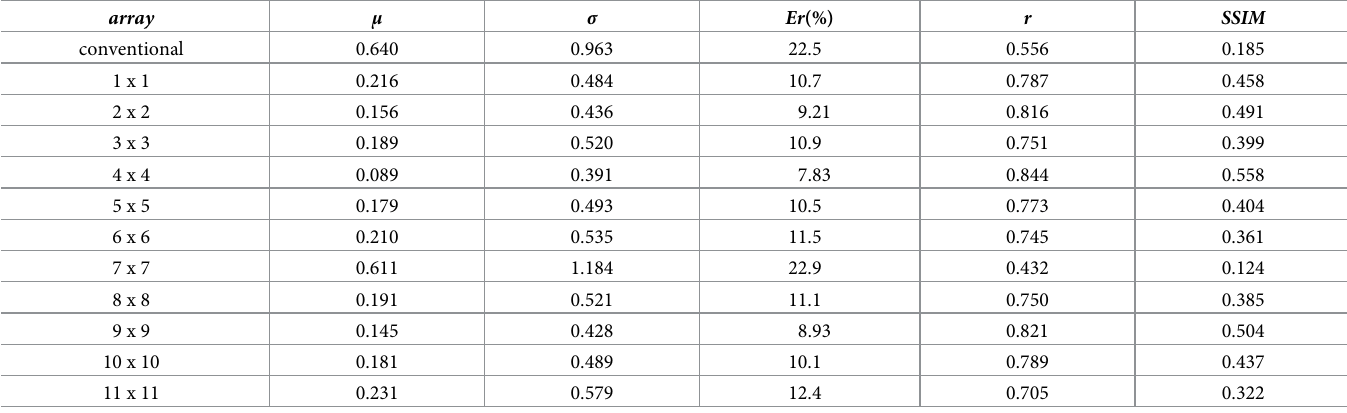
Table 1. Table with the main statistics of the numerical experiments. We focus our analysis on the red square region in Fig 2(a). The statistics μ , σ , and Er are based on the misfit between the model and the reconstruction. The quantities r and SSIM measure similarities between the images. The best results correspond to the 4x4 and 10x10 AFA